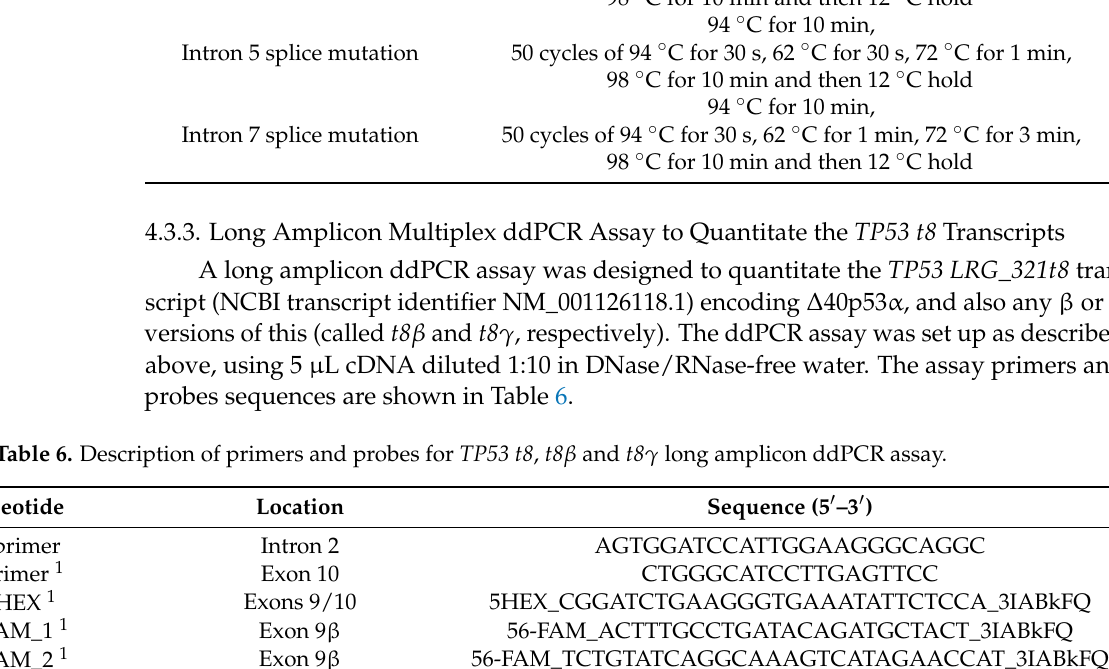
Table 5. Long amplicon ddPCR cycling conditions for the TP53 splice mutation assays. Assay Intron 4 splice mutation